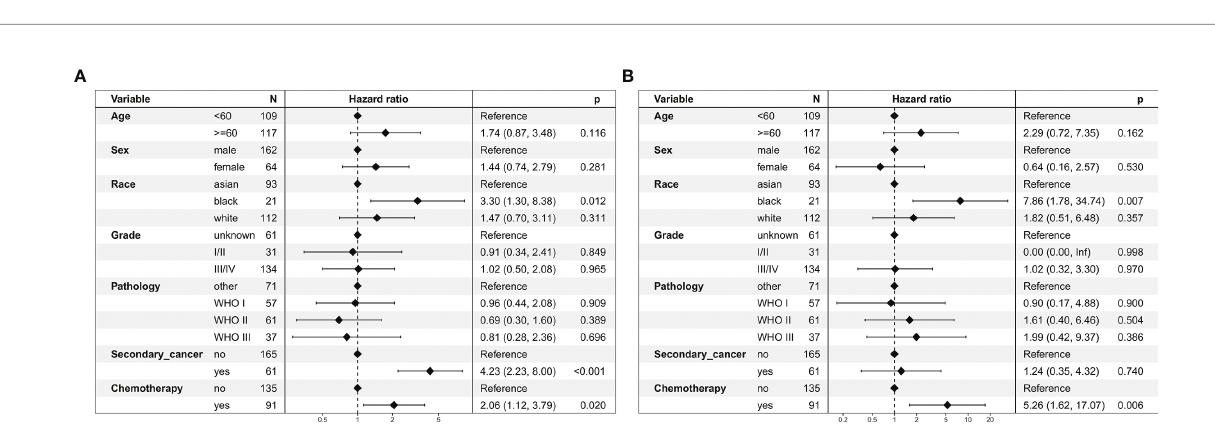
FIGURE 4 | Multivariate regression analysis of prognostic factors for patients with stage I nasopharyngeal carcinoma in the unmatched cohort. (A) Overall survival. (B) Cancer-speci fi c survival.